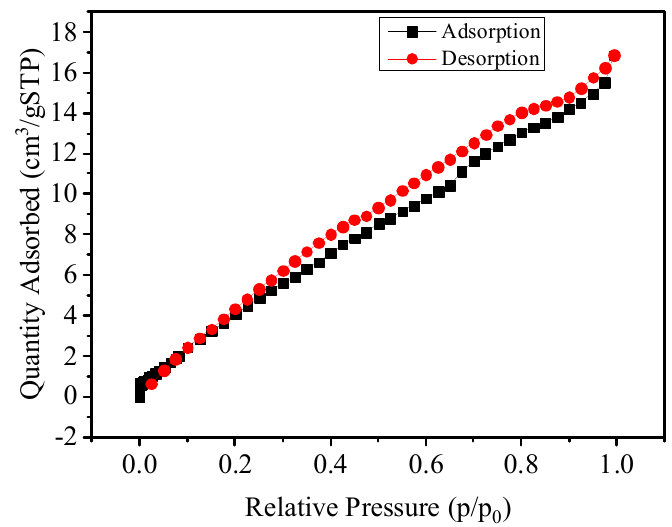
Figure 3. Nitrogen adsorption–desorption isotherm of PGO